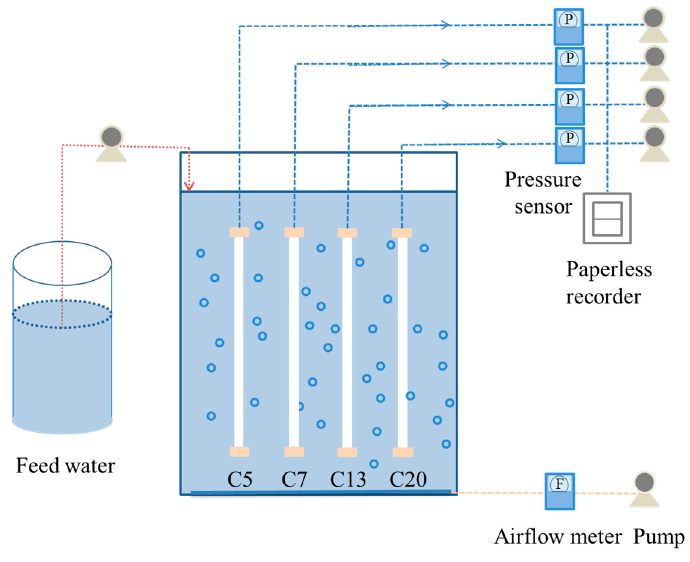
Figure 2. Schematic diagram of the MBR system.